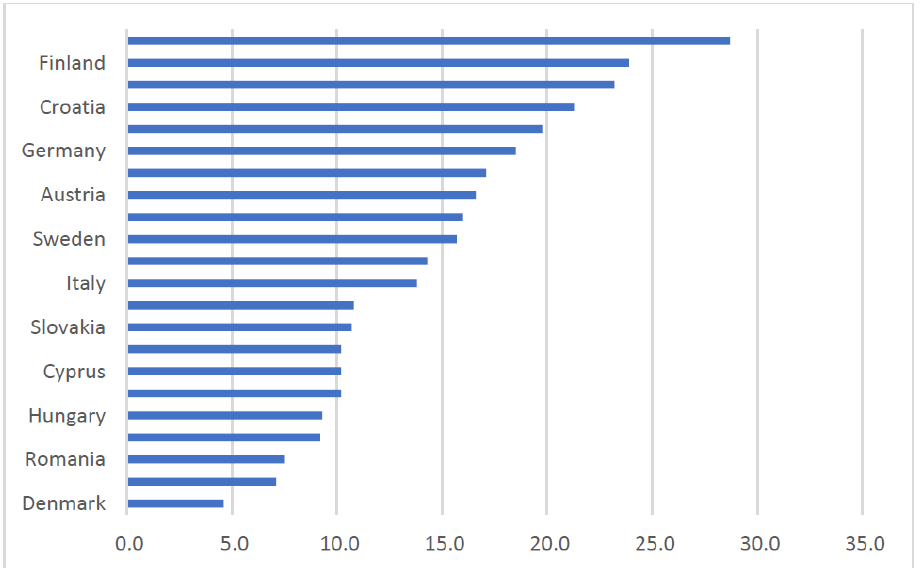
Figure 5. Share of enterprises facilitating recycling. Source: Own representation based on Eurostat data [34] .